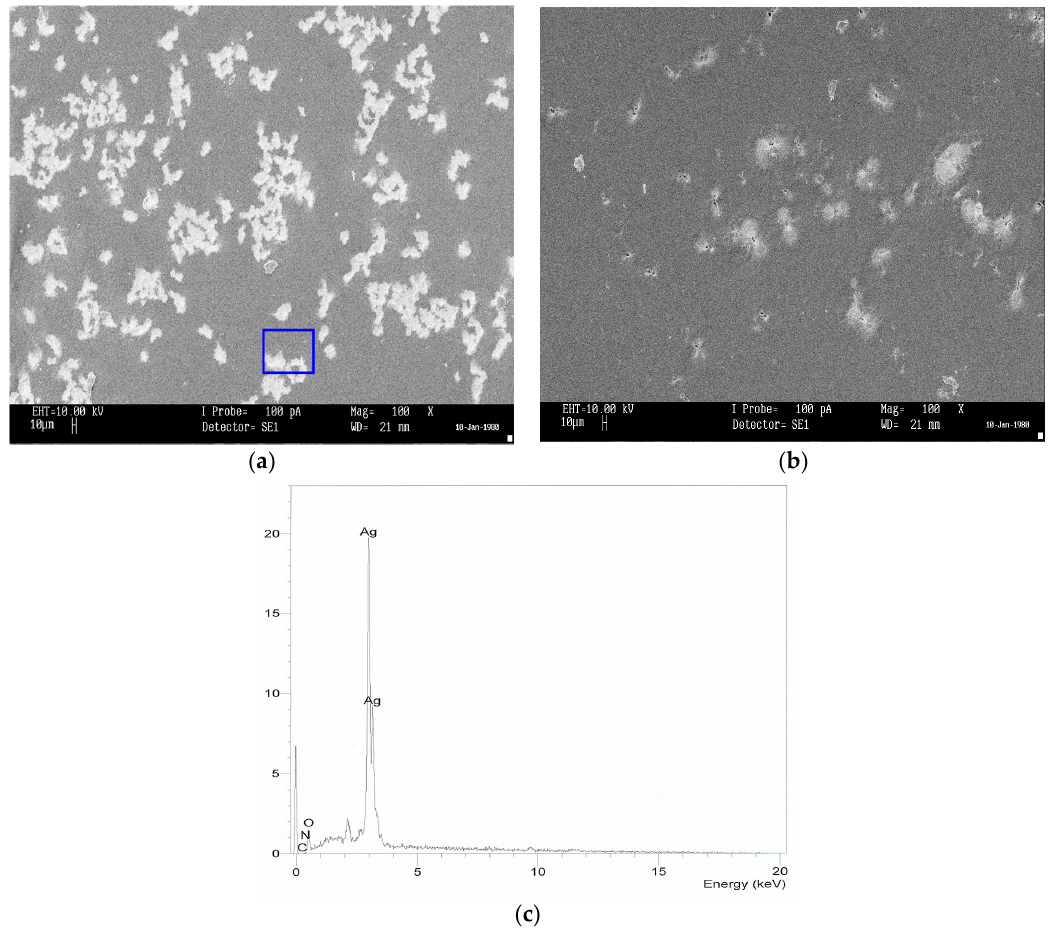
Figure 4. SEM image for: ( a ) SPE2; and ( b ) SPE3; and ( c ) EDX for white specs inside the blue box. The white specs appearing on the film surface are attributable to metallic silver particles.